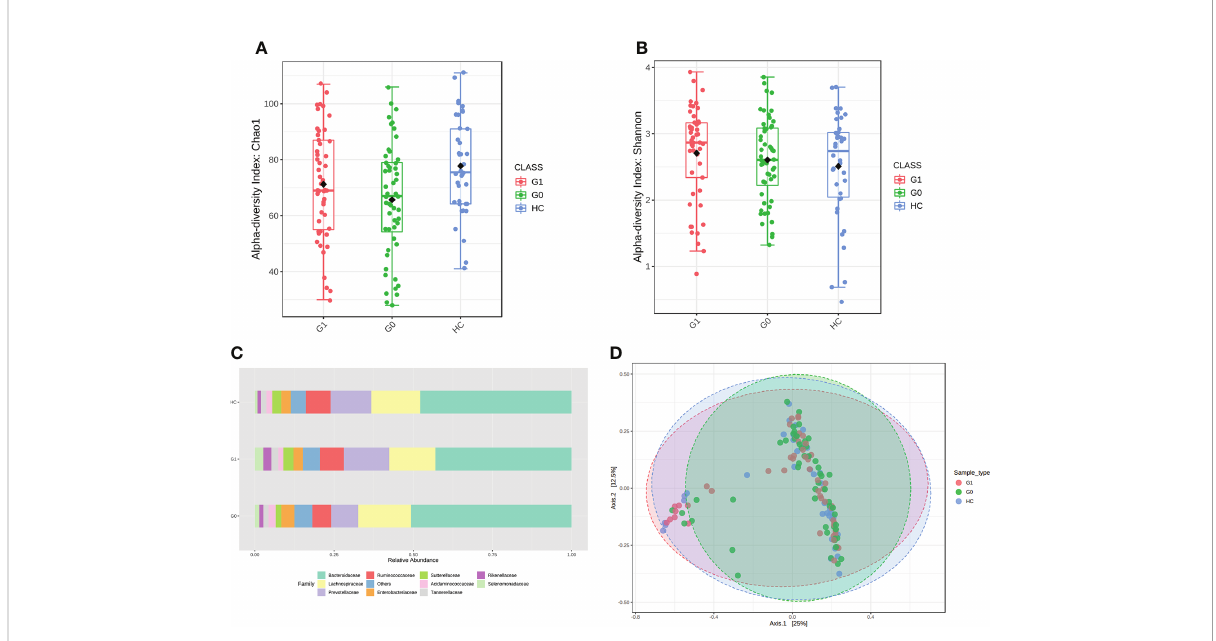
FIGURE 1 Results of diversity and structure pro fi le. (A, B) Box plot of differences in a -diversity of the gut microbiota of Chao1 (A) and Shannon index (B) respectively, the difference of Chao1 index (ANOVA, p-value: 0.0148, F-value: 4.349), the difference of Shannon index (ANOVA, p-value: 0.439, F-value: 0.827) among the three study groups. (C) The stacked bar plots at the family level. (D) PCoA plot of b -diversity of the Bray – Curtis index shows microbial communities ’ distance. (Permutational multivariate analysis of variance (PERMANOVA), F= 1.3449, R-squared= 0.019364; p< 0.128]. G0, GADA-; G1,